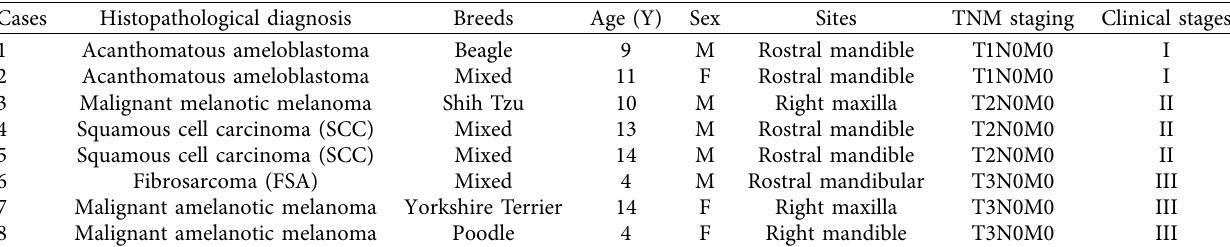
Table 3: Te histological diagnosis, signalments, the site of oral mass, TNM staging, and the clinical stage of dogs in the oral mass group. Cases